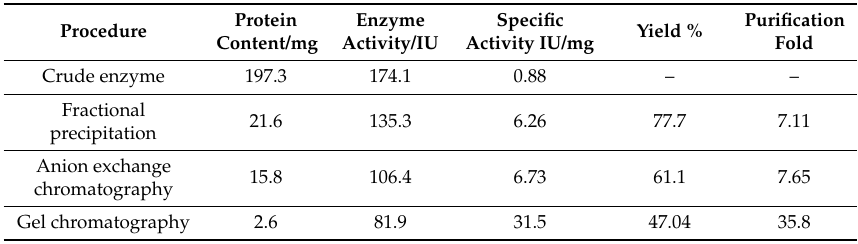
Table 2. Results for purification of cellulose from T. virens ZY-01 culture broth.